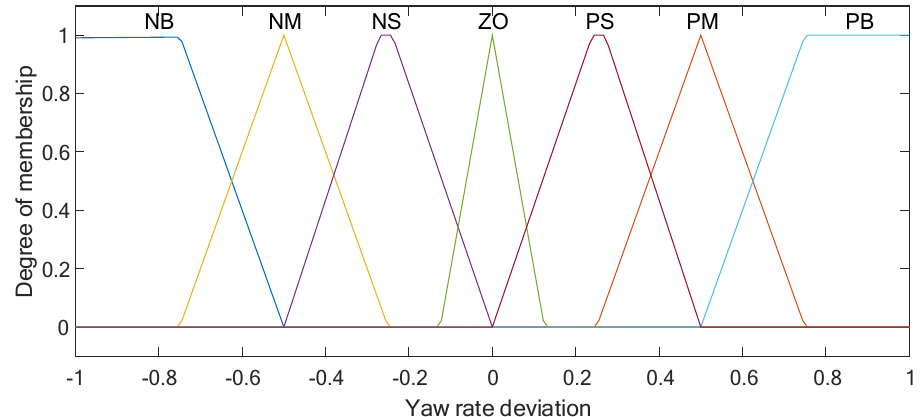
Figure 8. Membership function of the yaw rate deviation.